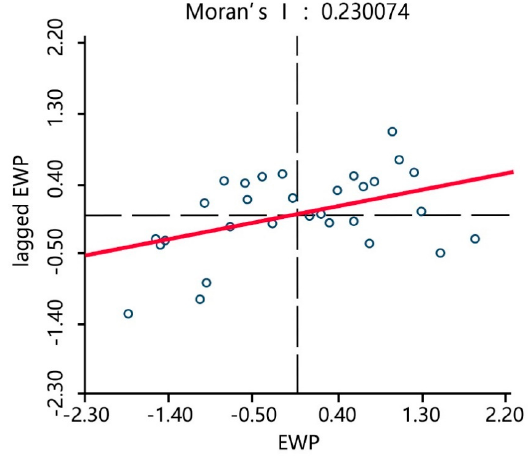
Figure 9. Moran ’s EWP scatterplots of the 30 provinces in 2011.